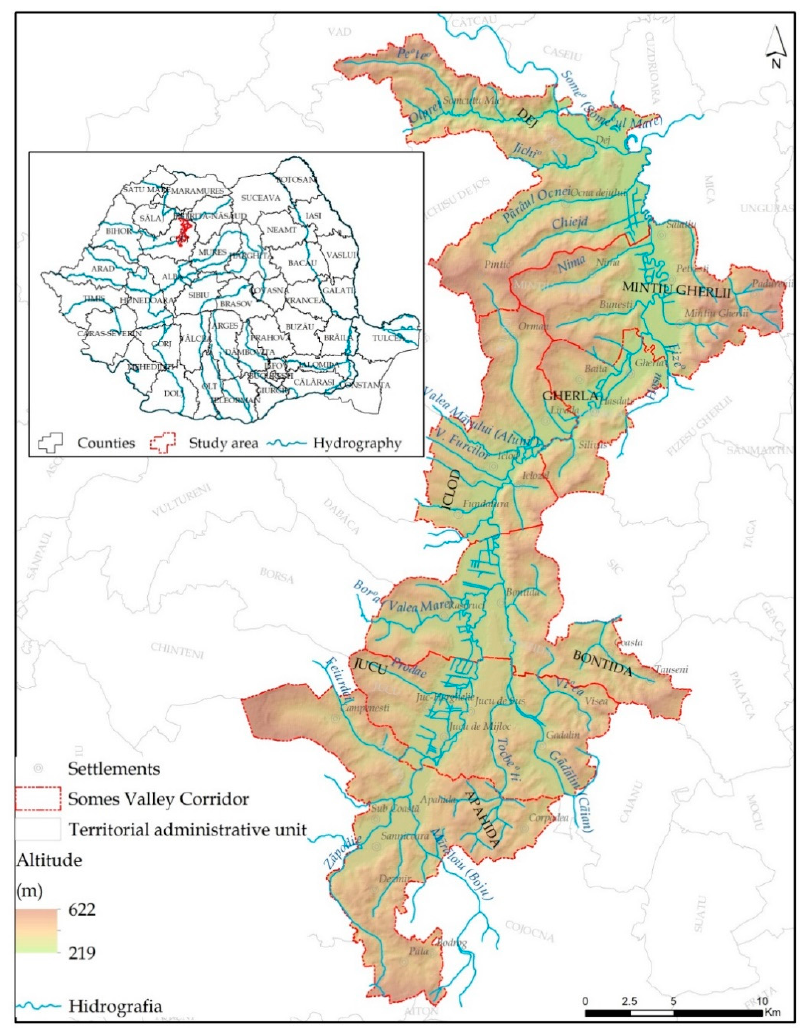
Figure 1. Geographical position of the Some ș Valley Corridor.